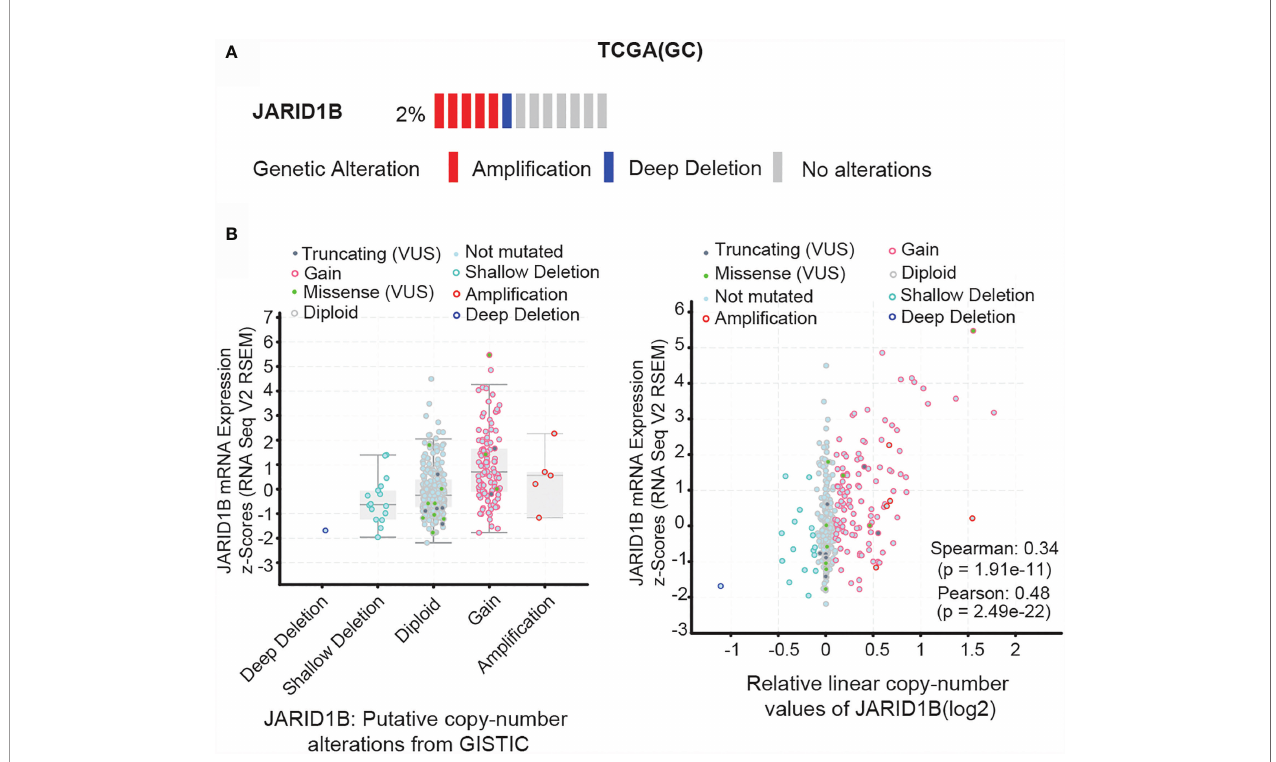
FIGURE 3 | Gene ampli fi cation of JARID1B in gastric cancer (GC). (A) cBioPortal (http://www.cbioportal.org/) analysis of the JARID1B genetic ampli fi cation in The Cancer Gene Atlas (TCGA) GC tissues. (B) Correlation between JARID1B copy number alteration and the messenger RNA (mRNA)